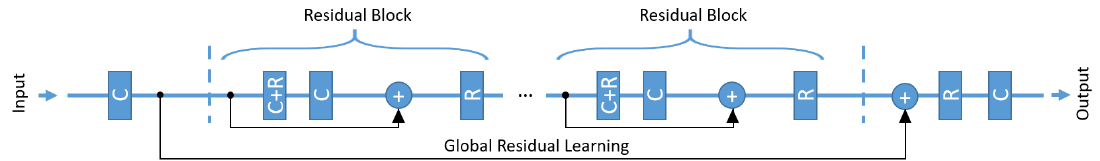
Figure 5. The HSCNN-R architecture [46]. “C” means 3 × 3 convolution and “R” refers to the ReLU